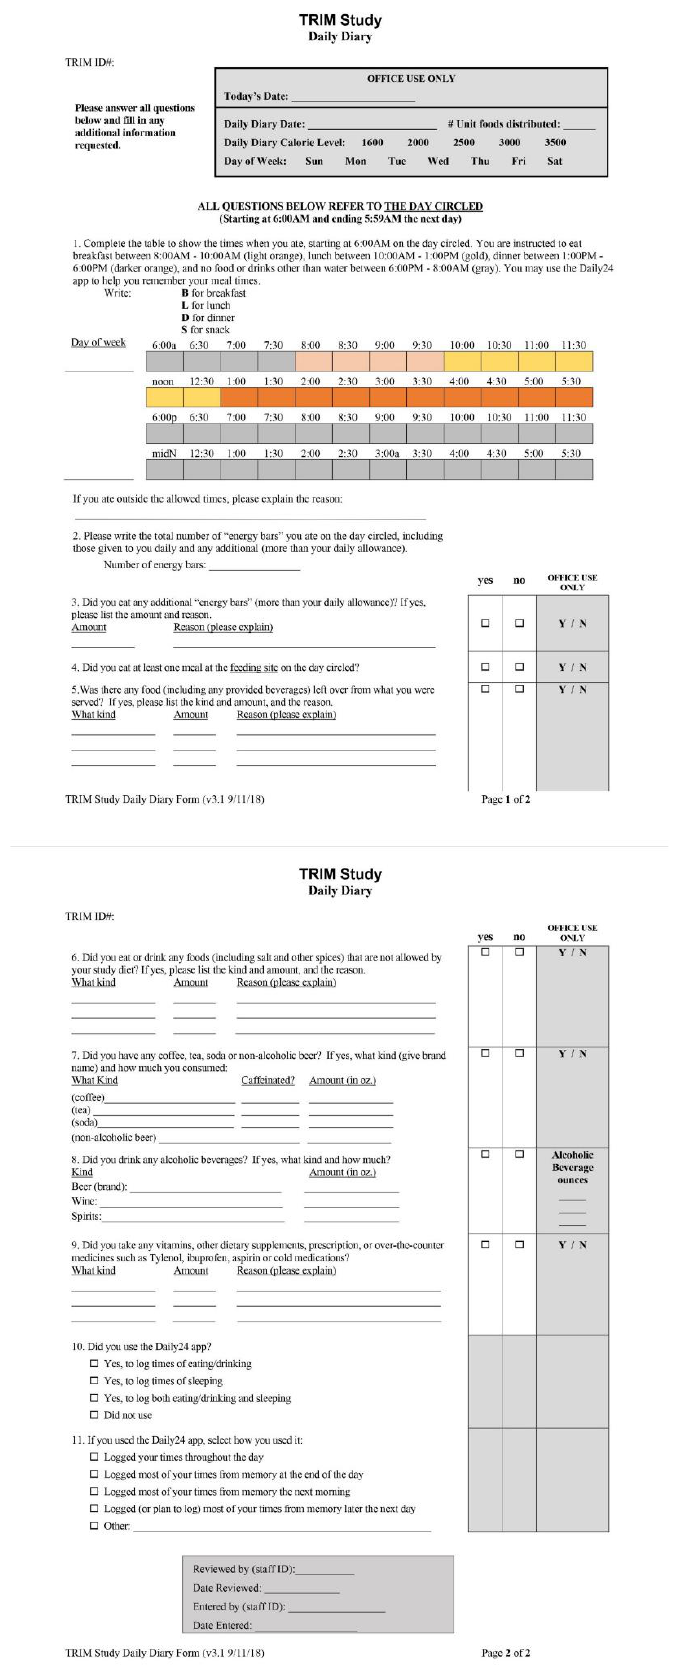
Figure A1. Daily diary form used for adherence measurement in the time-restricted feeding arm.